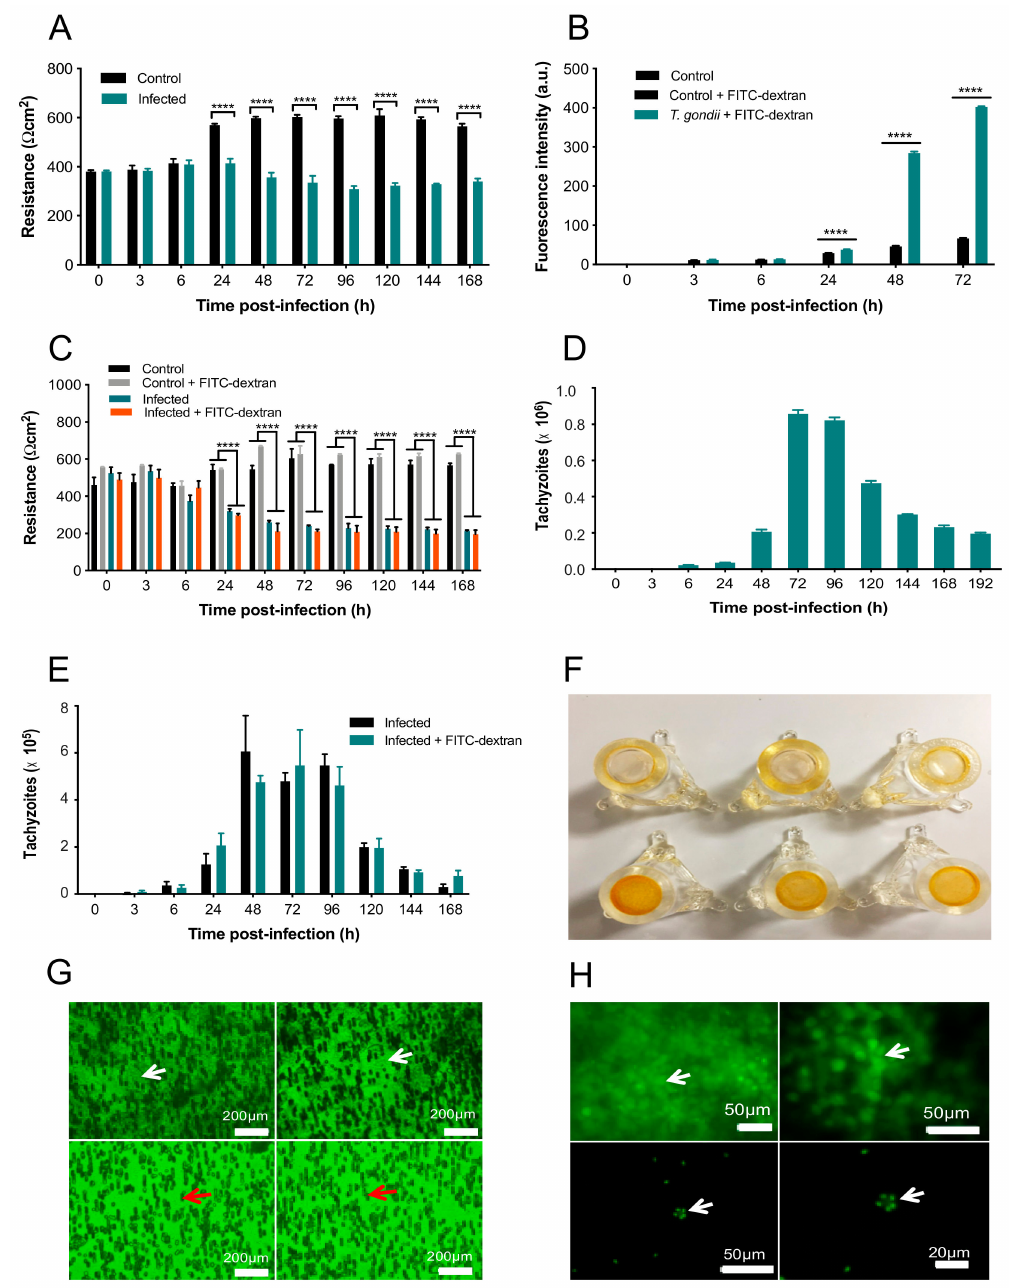
Figure 6. T. gondii compromised the BMEC monolayer integrity. ( A ) Infected cells show decreased resistance compared to controls from 24 h onwards. ( B ) T. gondii significantly increased FITC-dextran flux in the cell monolayer compared to control BMECs + FITC-dextran. ( C ) Resistance was decreased in infected, compared to control, cells from 24–168 h, regardless of the presence or absence of FITC-dextran. ( D ) There was a large number of tachyzoites crossing the cell monolayer after 48 h. There was still, however, a small number of tachyzoites crossing between 6 and 24 hpi and the numbers started declining after 96 hpi. ( E ) There was no di ff erence between the number of parasites crossing the cell monolayer in infected cells in the presence or absence of FITC-dextran ( p > 0.05), suggesting the decreased integrity of the cells was due to T. gondii only. ( F ) Inserts containing uninfected control cells displayed dark even orange staining (bottom row). Inserts with T. gondii -infected cells displayed